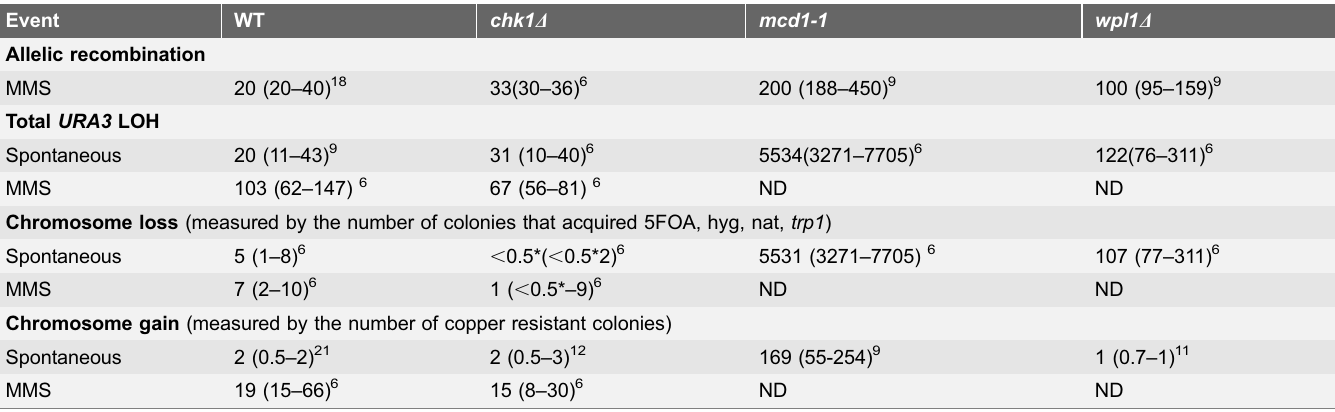
Table 2. Median rates of genome instability events (/10 7 cell divisions).